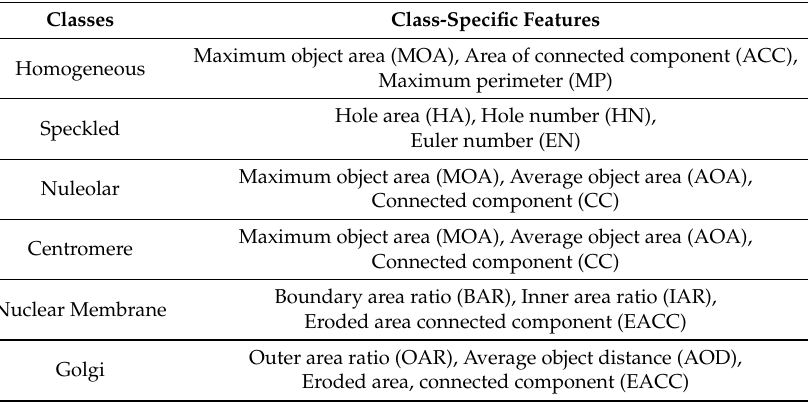
Table 1. Class-specific features for all